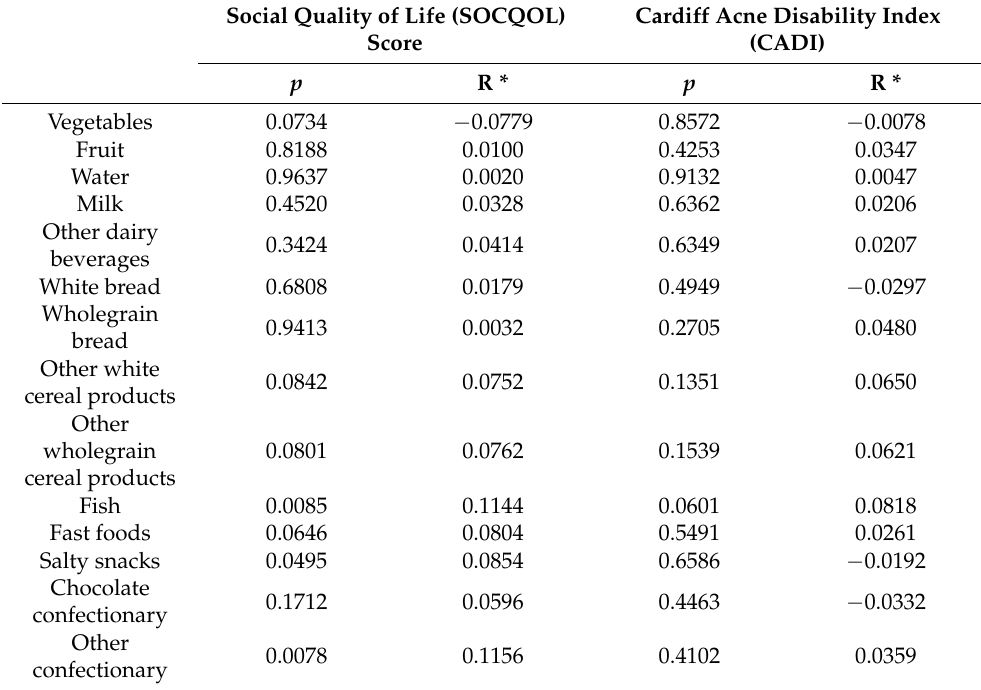
Table 5. Analysis of the correlation between the intake of acne-related food products obtained based on the Acne-specific Food Frequency Questionnaire (Acne-FFQ) and the results of the Social Quality of Life (SOCQOL) Score obtained based on the Acne Quality of Life (AQoL) scale, as well as the Cardiff Acne Disability Index (CADI) obtained based on the Acne Disability Questionnaire (ADQ) in the studied group of male adolescent participants of the